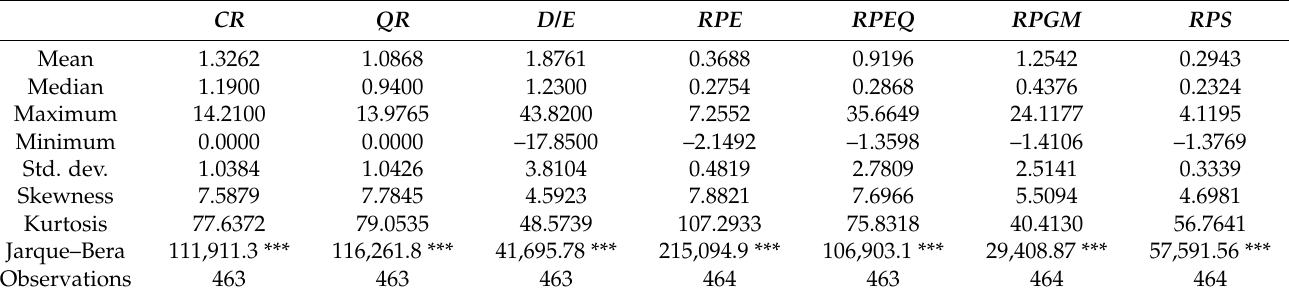
Table 3. Descriptive statistics for oil